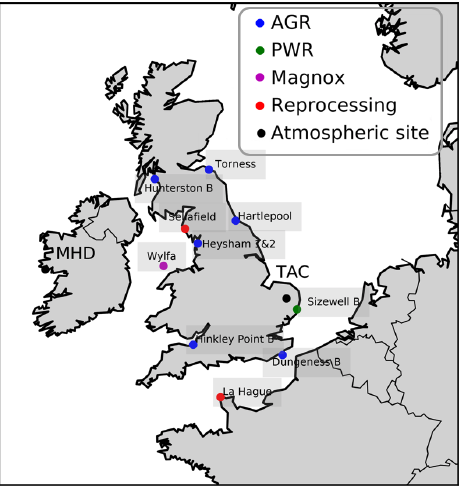
Figure 1. Map of north-western Europe nuclear power stations and other nuclear facilities. Reactor types are the advanced gas-cooled reactor (AGR) (blue), pressurized water reactor (PWR) (green), and Magnox (pink). Fuel reprocessing sites are labelled separately (red). The atmospheric measurement sites (Tacolneston, TAC, and Mace Head, MHD) are also labelled (black).